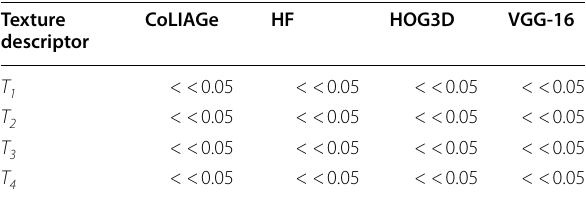
Table 9 P -values comparing proposed methods to comparison methods using Wilcoxin ranked sum